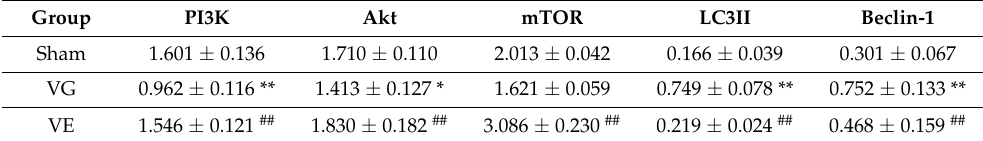
Table 4. The RT-PCR detection results of the hippocampus of vascular dementia rats with aerobic exercise intervention ( n = 6).